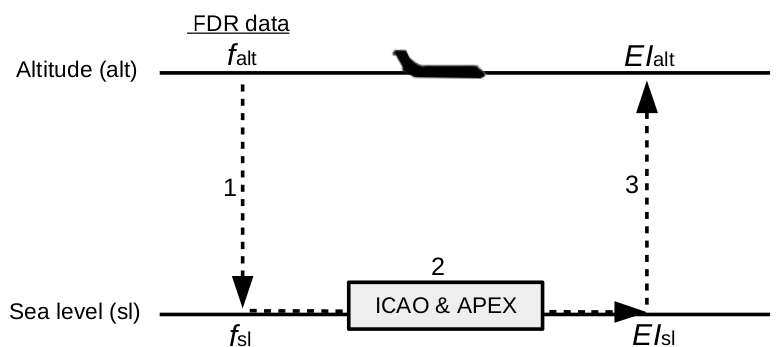
Figure 1. Boeing Fuel Flow Method 2 process applied for emissions